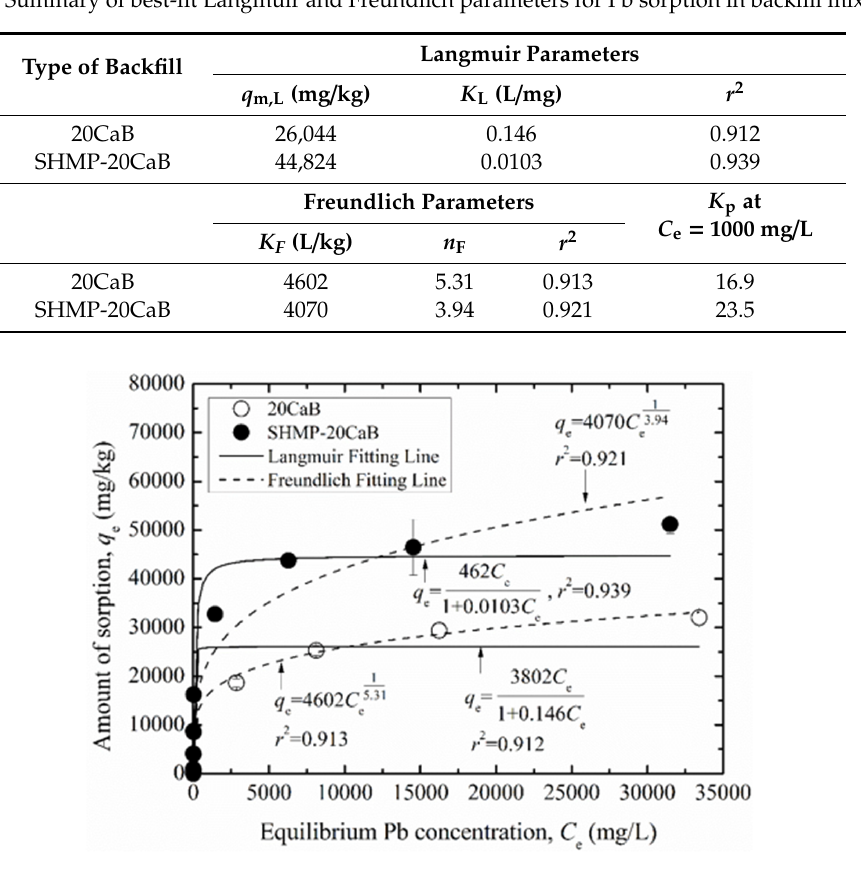
Figure 4. Langmuir and Freundlich sorption parameters for unamended and amended backfills. Based on the Langmuir model, sorption capacities of the unamended and amended backfills are 26,044 mg / kg and 44,824 mg / kg, respectively. This indicates an increase in sorption capacity of the backfill by factor of 1.72 times with the SHMP amendment. The increase in Pb sorption capacity of the amended backfill is attributed to: (1) increased surface area of the CaB by the SHMP. The grain size of the CaB decreases and the surface area increases after amended by the SHMP [38], thus providing more sites for Pb sorption. As the CaB possesses lower surface area, the unamended backfill possesses lower sorption capacity; (2) increased surface charge density of the CaB by SHMP. The